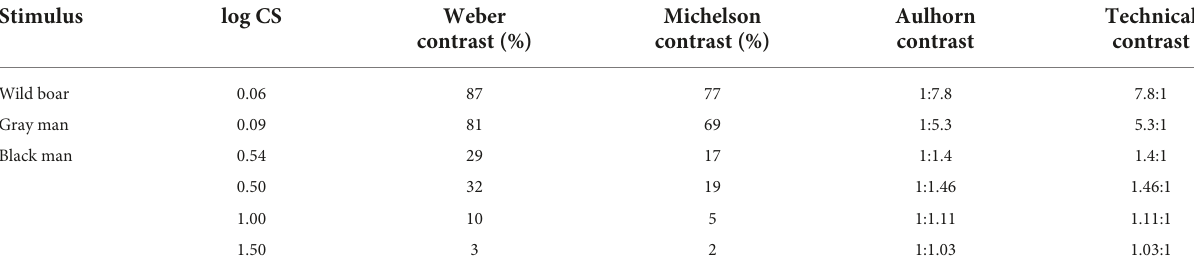
TABLE 1 Relation between different contrast definitions (see Bach et al.,